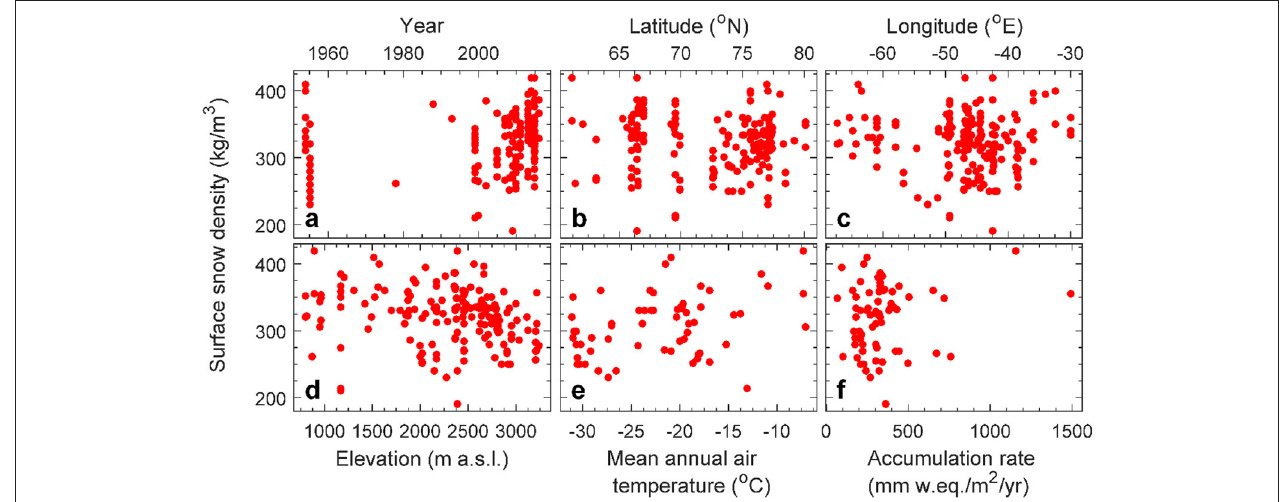
FIGURE 2 | Density of the top 0.1m of snow plotted against site- and campaign-specific parameters: (a) year, (b) latitude, (c) longitude, (d) elevation, (e) annual mean near-surface air temperature, and (f) accumulation rate.